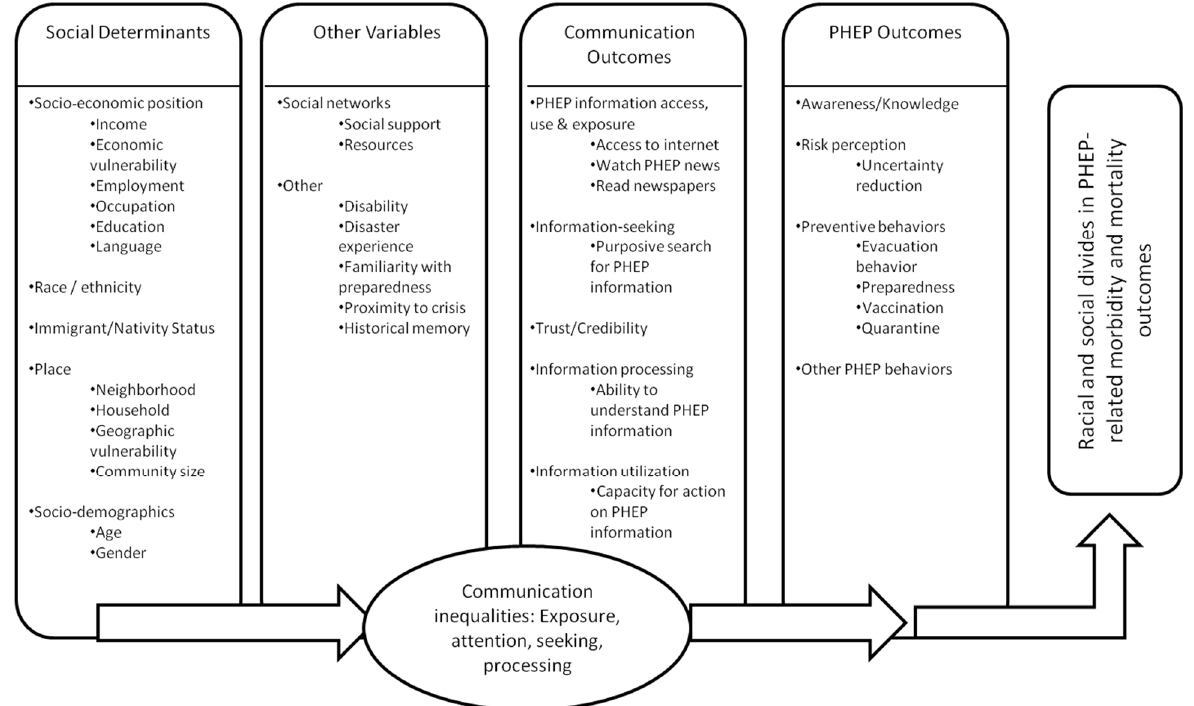
Figure 1. Structural Influence Model of PHEP